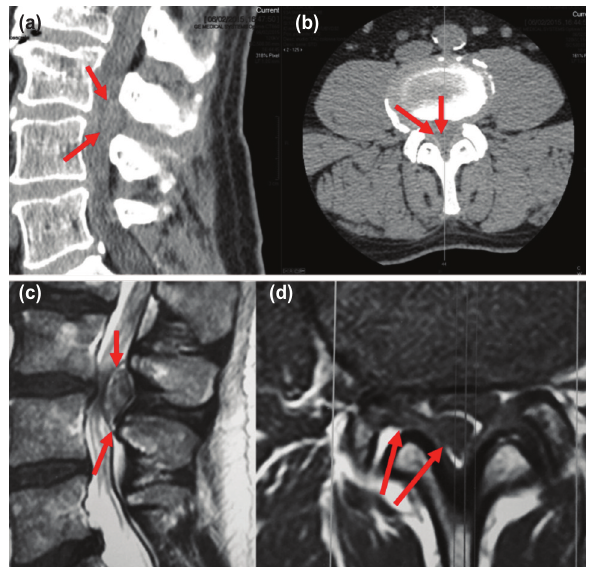
(a, b) Sagittal and axial CT-scan images that showed a ill- Fig. 1: defined rounded lesion localised in the posterior epidural space at L3-L4 lumbar level (arrows). Diagnosis was difficult due to the low quality of definition. (c, d) Sagittal and axial images on T2-weighted MRI focused on the indexed lumbar level that clearly showed the presence of a large fragment of disc material migrated posteriorly to the dural sac that caused severe cauda equine compression.